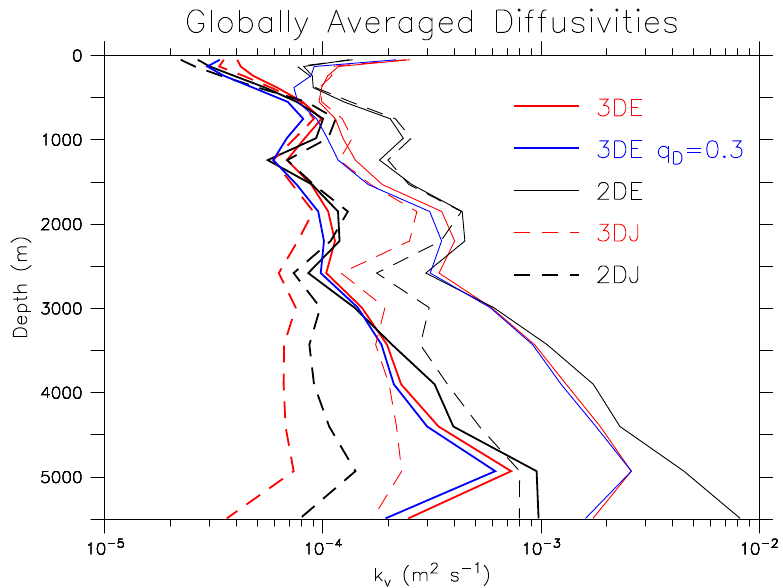
Fig. 5. Global mean profiles of diffusivities for experiments with (3-D, red) and without (2-D, black) the subgrid-scale bathymetry scheme. Solid lines use energy flux out of the barotropic tide estimated from satellite altimetry (ER03) and dashed lines model-based estimates from JS01. Thick and thin lines use observed (model day 10) and modeled (model year 4000) N 2 , respectively.